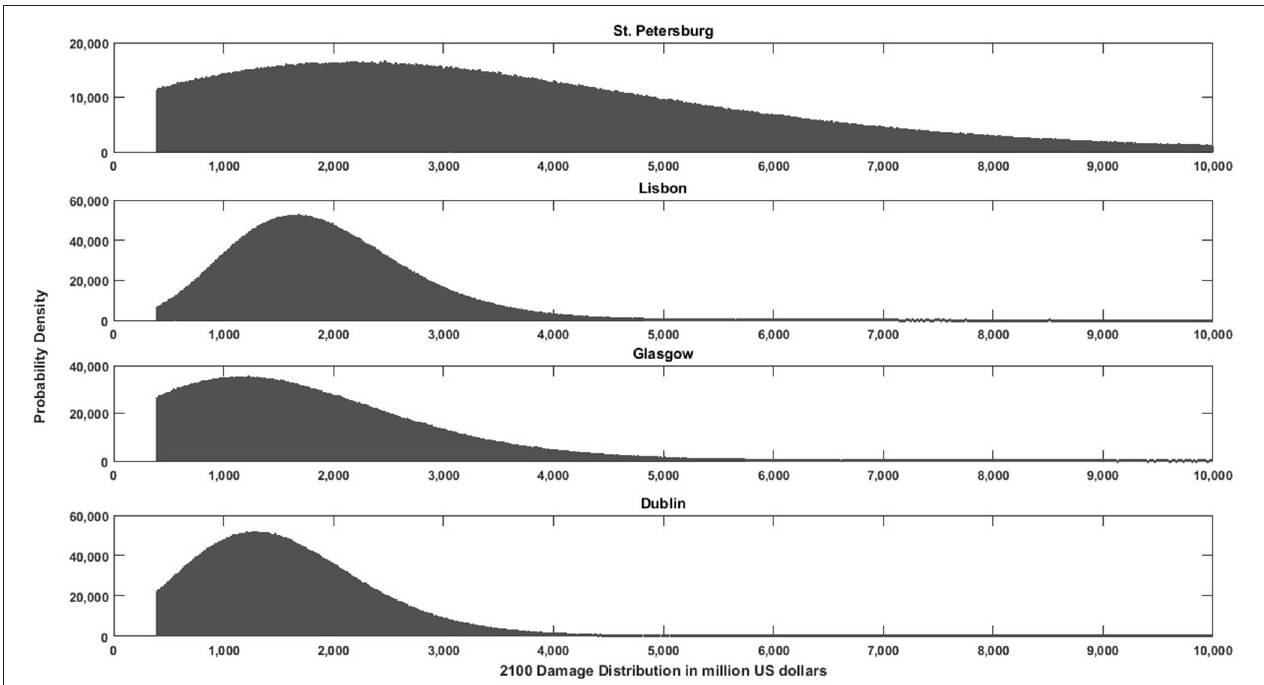
FIGURE 3 | Damage distribution in 2100 and uncertainty distributions under RCP8.5 for the European cities ranked 4–8 in Table 4. Note that the vertical scale differs depending on the city.